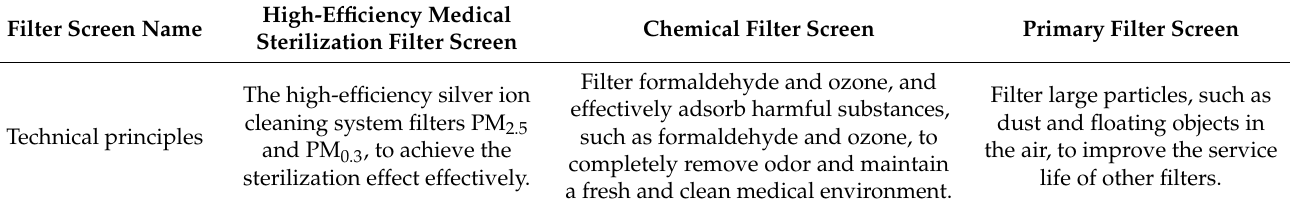
Figure 18. P-Q curve of the primary filter screen. Table 3. Technical principles for air purifier filter screens [24].